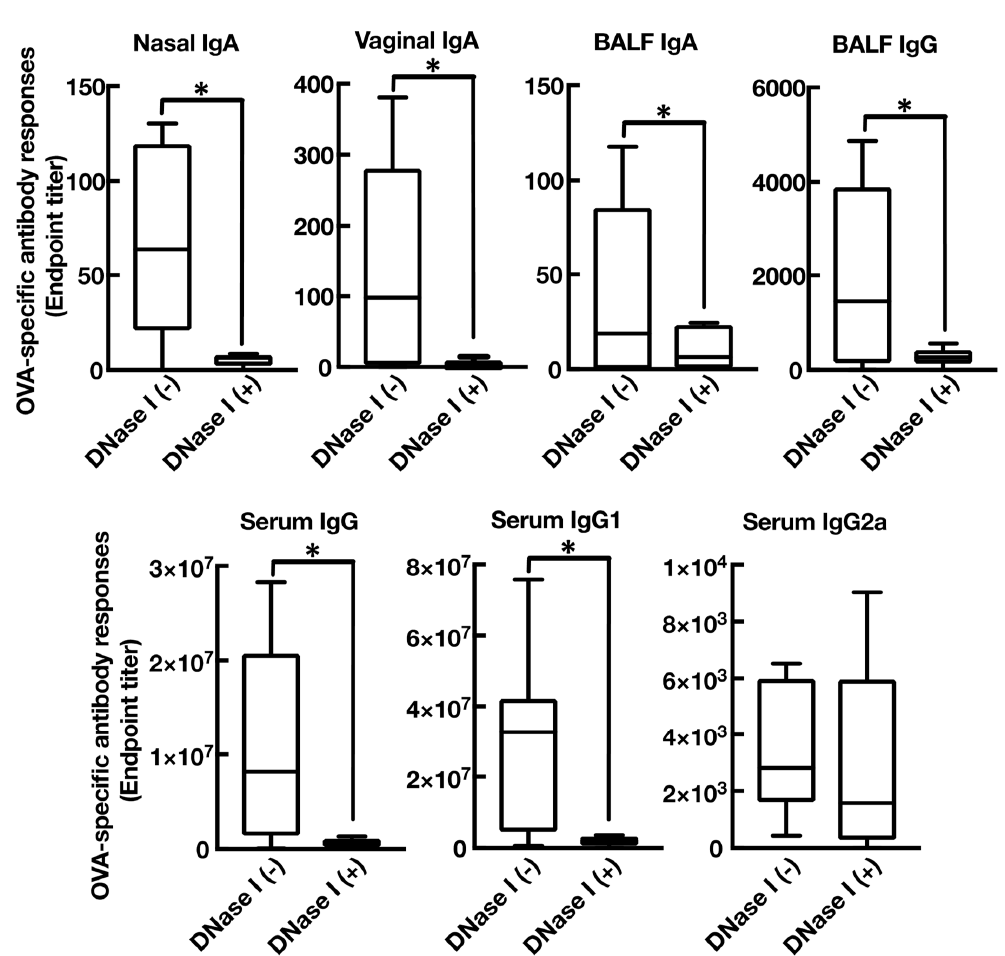
Figure 5. DNase I treatment diminishes antigen-specific antibody responses in BALB/cCrSlc mice immunized with OVA in combination with dsDNA. BALB / cCrSlc female mice were immunized immunized with OVA in combination with dsDNA. BALB/cCrSlc female mice were immunized intranasally (days 0, 7, and 14) with OVA (2.5 µ g / mouse) together with dsDNA (50 ng / mouse) or intranasally (days 0, 7, and 14) with OVA (2.5 μ g/mouse) together with dsDNA (50 ng/mouse) or OVA (2.5 µ g / mouse) together with dsDNA (50 ng / mouse), followed by immediate injection of